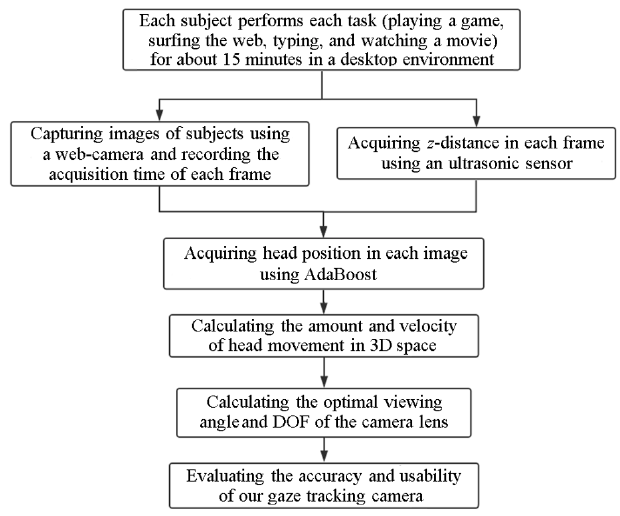
Figure 2. Overall procedure of the proposed method.